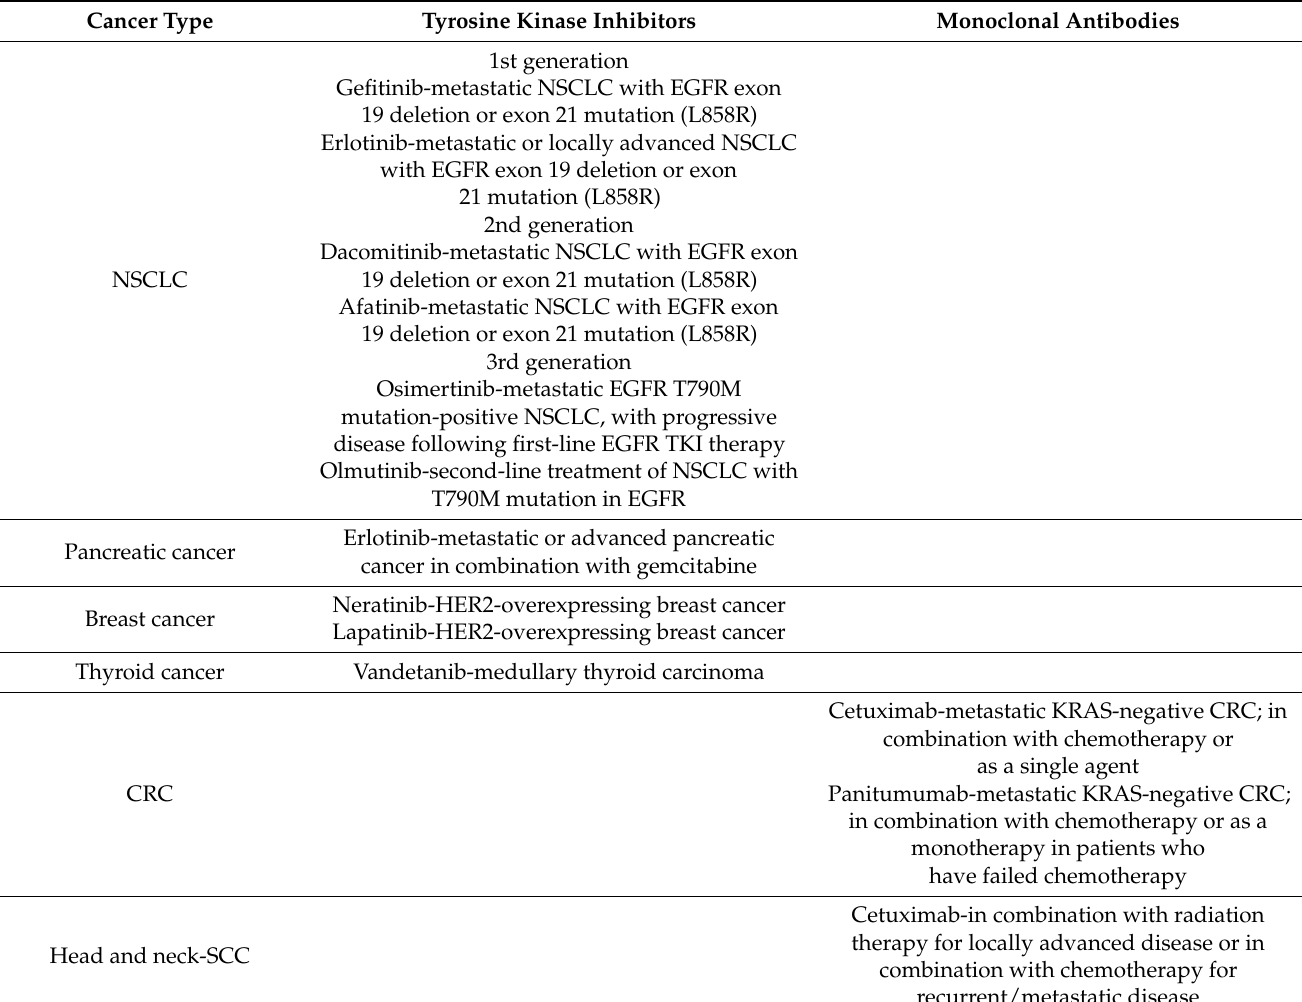
Table 2. Currently approved anti-EGFR therapies and their